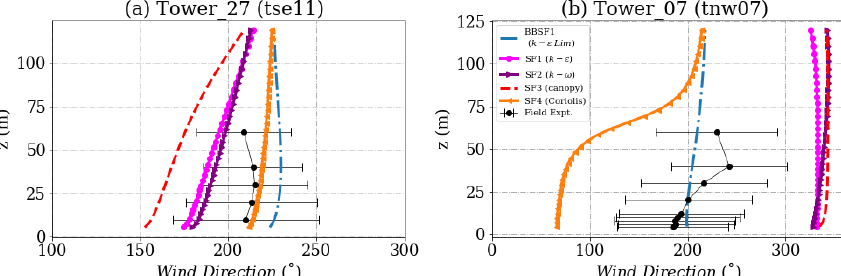
Figure 14. Simulation results and experimental data for wind direction inside the valley for (a) Tower 27 (tse11) and (b) Tower 7 (tnw07). The locations of the masts are given in Fig.